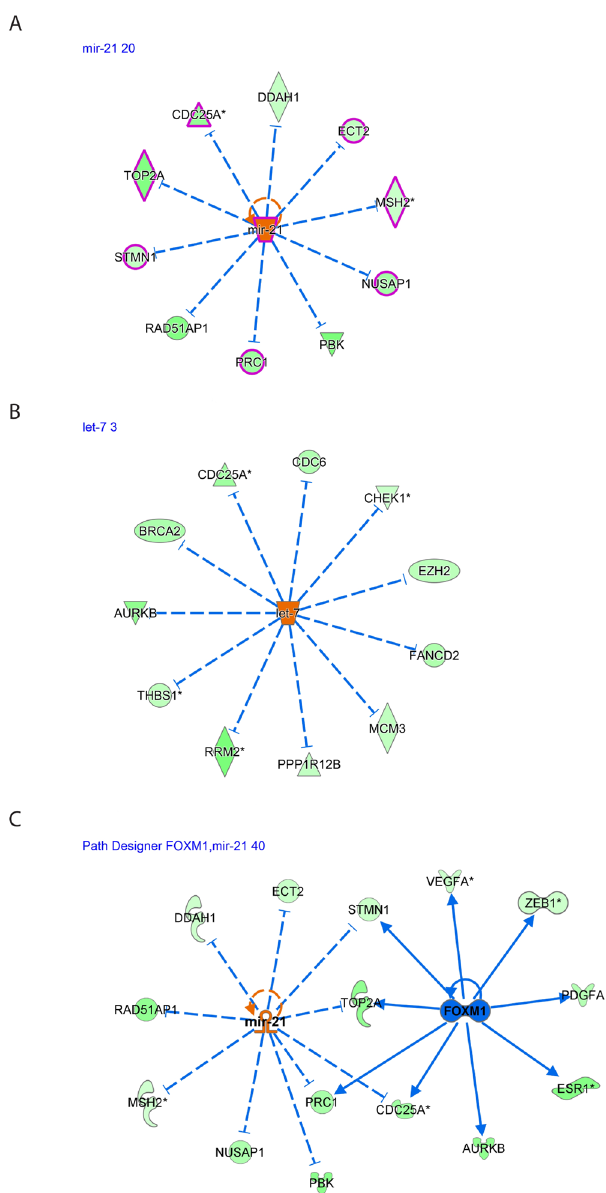
Figure 3. The resultant DE miRNAs were analyzed through the use of IPA (Ingenuity Pathway Analysis, QIAGEN Inc., https://www.qiagenbioinformatics.com/products/ingenuitypathway-analysis) 19 to explore the inversely correlated miRNA-regulated pathways and mRNA expression in preovulatory granulosa cells. This analysis revealed that both ( A ) miR-21 and ( B ) let-7 are involved in the downregulation of several important genes. ( C ) Putative crosstalk between the FOXM1 signaling pathway and miR-21 signaling. A number of genes and pathways are reciprocally regulated by these negatively correlated transcription regulators. mir-21 expression is upregulated, whereas FOXM1 expression is downregulated during the ovulatory